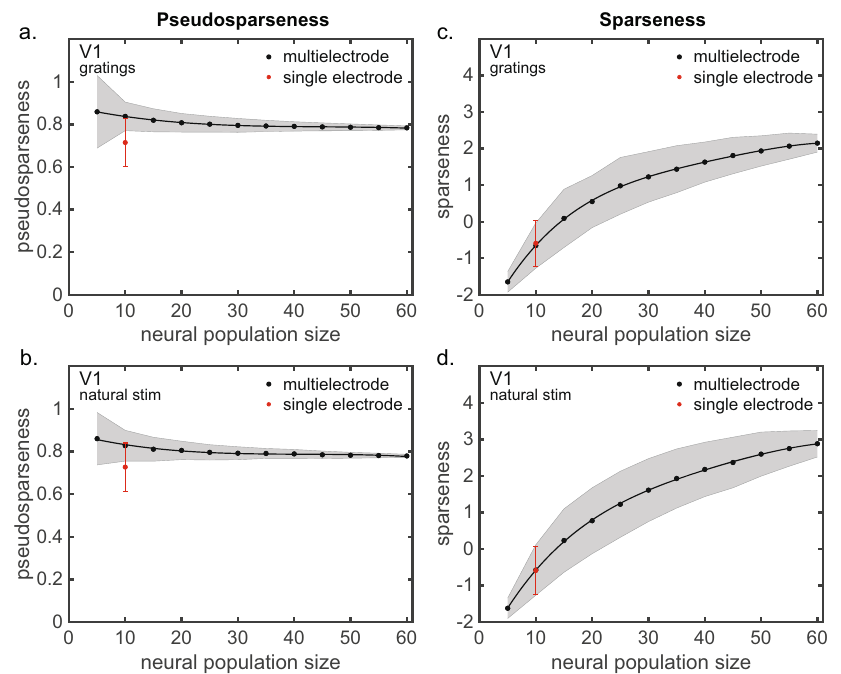
Fig. 4 Comparison between multielectrode and single-electrode V1 data for pseudosparseness and sparseness values as a function of population size. a Comparison of pseudosparseness using grating stimuli. b Comparison of pseudosparseness using natural stimuli. c Comparison of sparseness using grating stimuli. d Comparison of sparseness using natural stimuli. Single-electrode population was synthesized from multielectrode data by selecting one cell from different multielectrode recording sessions from the same data set. Multielectrode data was subsampled to produce various population sizes. Entire curves were generated for completeness, but the critical comparison is that between the N = 10 single-electrode population and the N = 10 multielectrode population. N = 5 – 60 neurons on the x -axis with 10,000 resampled population activities based on n = 416 stimuli (gratings) or n = 540 stimuli (natural images) for each neuron (Data from Coen-Cagli et al. 29 ).